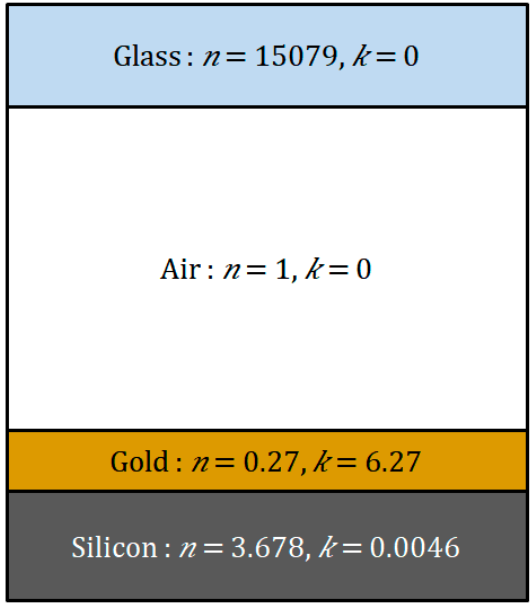
Figure 8. Schematic of the design used in simulations with corresponding refractive indexes.